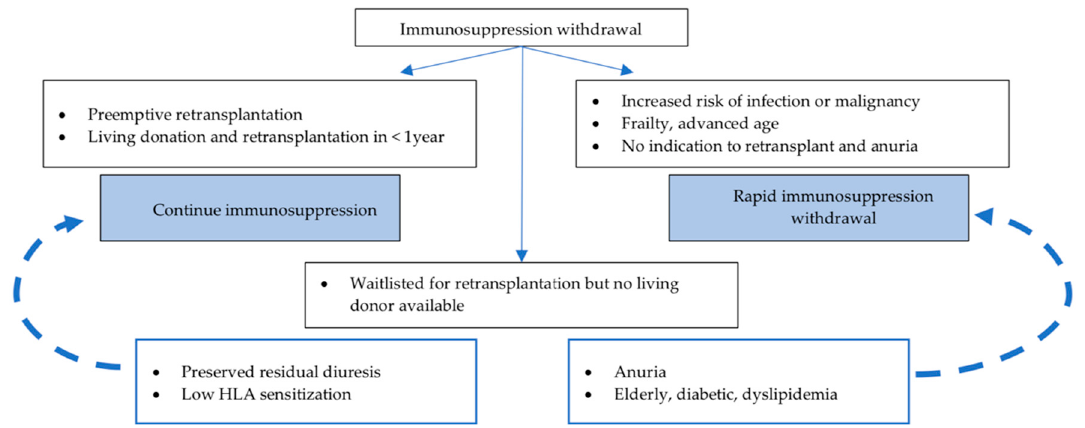
Figure 2. Suggested approach to immunosuppression withdrawal after graft loss. For patients waitlisted for retransplantation without an available living donor, the tendency (dashed arrows) to continue or withdrawal immunosuppresion, should be defined on an individual basis, according to residual diuresis, actual HLA sensitization and other comorbidities.